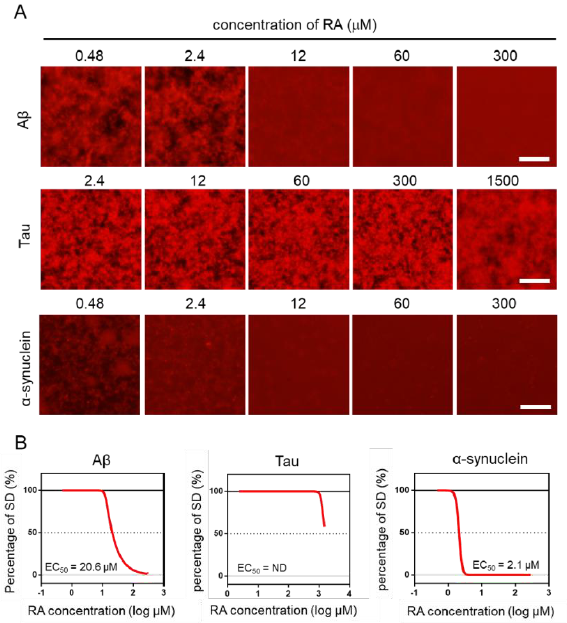
Figure 4. Estimation of EC 50 by the Microliter-Scale High-throughput Screening (MSHTS) system. ( A ) Fluorescence image of each amyloid protein treated by rosmarinic acid (RA). ( B ) Aggregation inhibitory activity of RA for 30-µM Aβ, 10-µM tau, and 6-µM α-synuclein. The SD values from the fluorescence images were plotted against several concentrations of inhibitors. EC 50 values were calculated from an inhibition curve (n = 3 independent experiments). Scale bar = 100 µm.